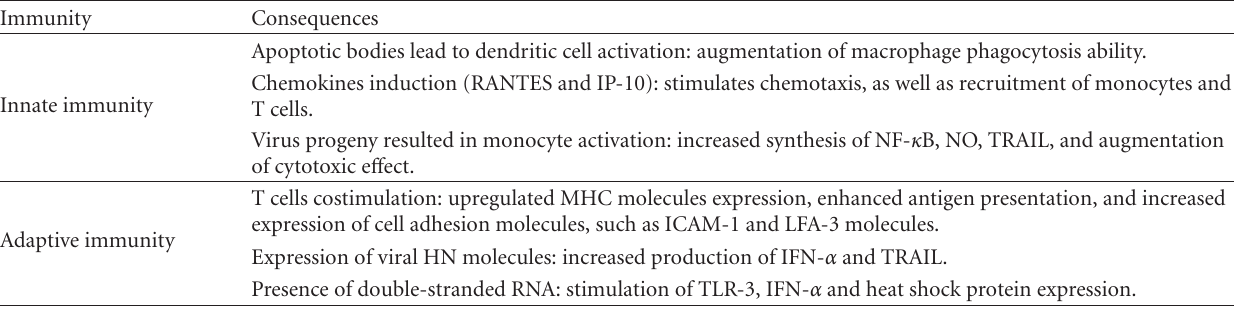
Table 1: Summary of the immunological properties of